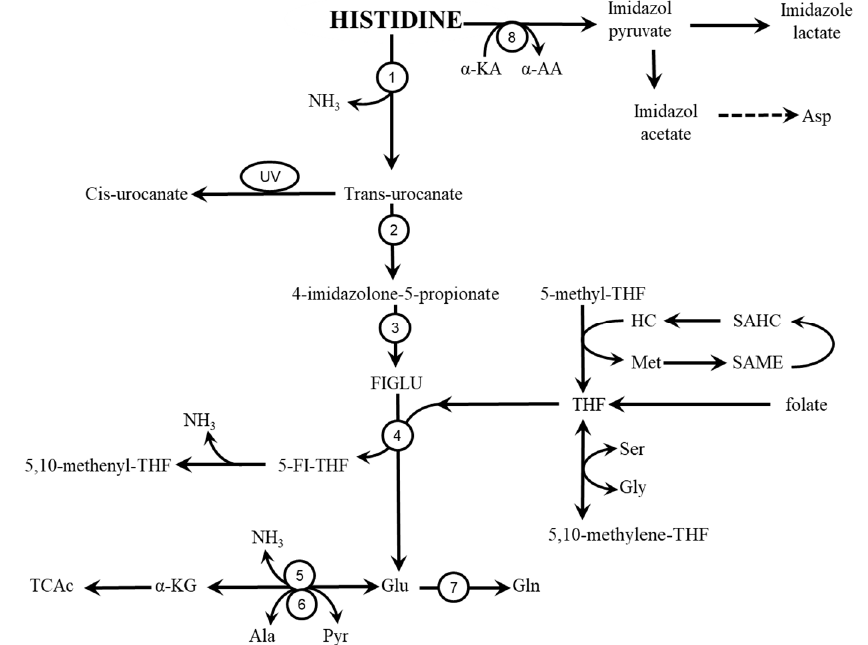
Figure 3. HIS catabolism. 1, histidase; 2, urocanase, 3, imidazolone propionate hydrolase; 4, glutamate formimino transferase; 5, glutamate dehydrogenase; 6, alanine aminotransferase; 7, glutamine synthetase; 8, histidine aminotransferase. Ala, alanine; Asp, aspartic acid; FIGLU, formiminoglutamate; Gln; glutamine; Glu, glutamic acid; Gln, glutamine; Gly, glycine; HC, homocysteine; Met, methionine; Pyr, pyruvate; SAHC, S-adenosylhomocysteine; SAME,S-adenosylmethionine; Ser,serine; THF,tetrahydrofolate; TCAc,tricarboxylic acid cycle; UV, ultraviolet radiation; α -AA, α -amino acid; α -KA, α -keto acid; α -KG, α